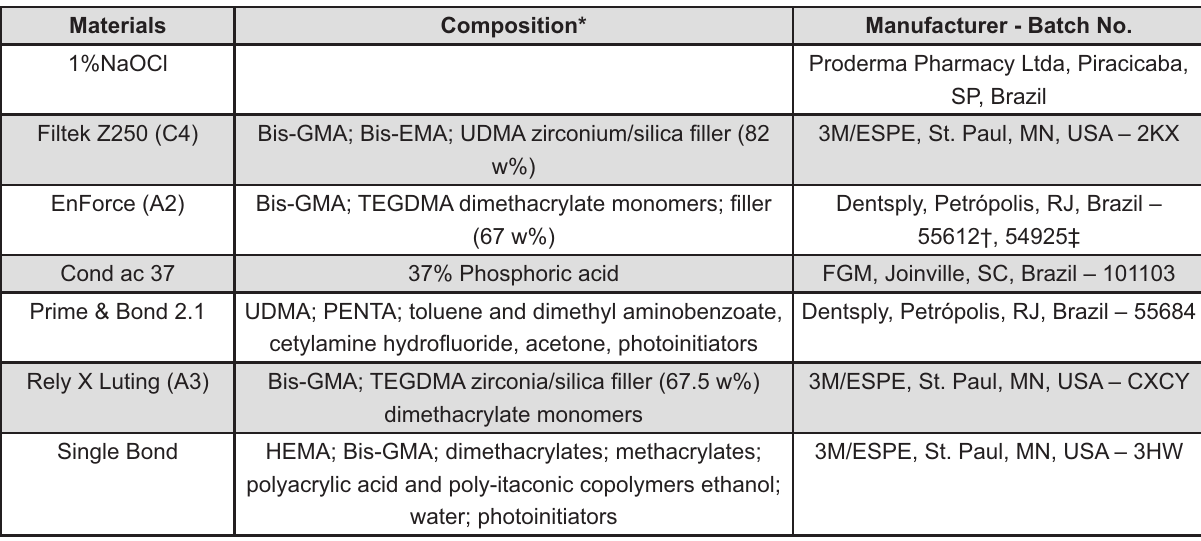
Figure 1- Description of materials used in this study